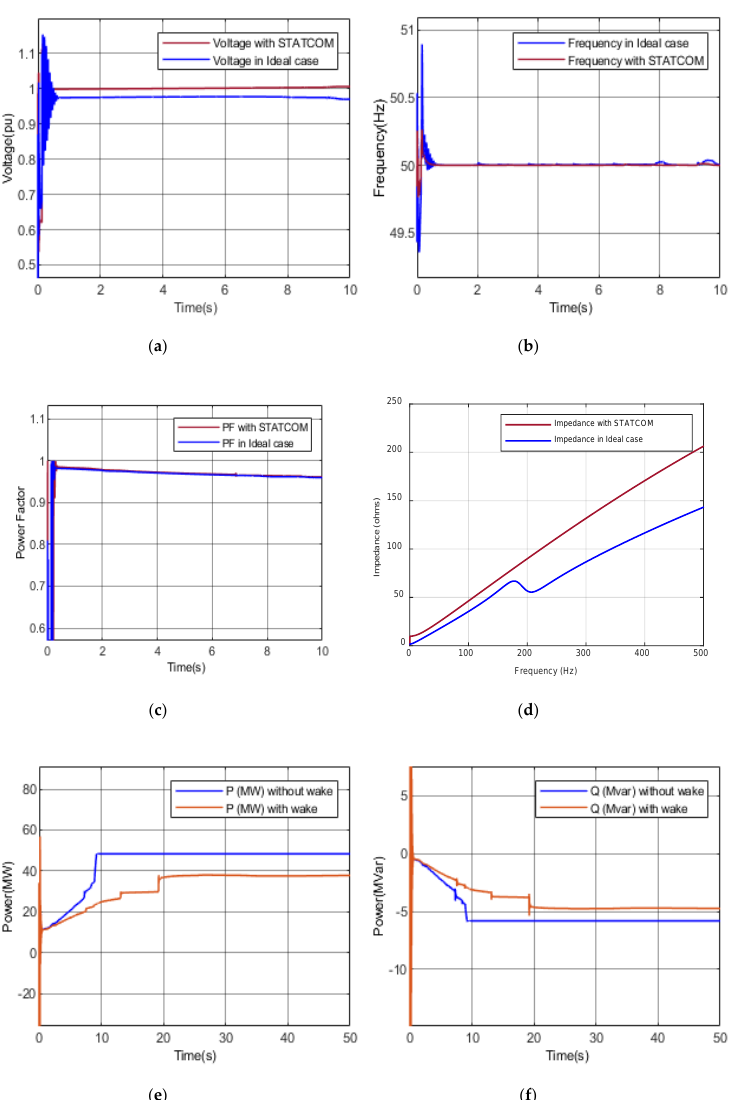
Figure 11. Case-2, Scenario 8: ( a ) Voltage (V) at PCC; ( b ) frequency (F) at PCC; ( c ) PF at PCC; ( d ) impedance (Z) vs. F; ( e ) P-trend; and ( f ) Q-trend.